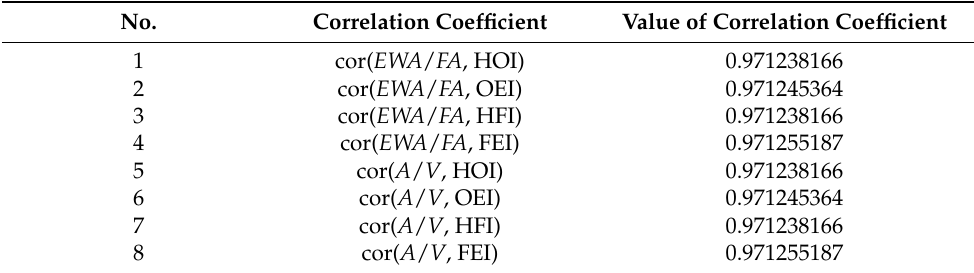
Table 6. The correlation coefficients of the EWA / FA and A / V (shape parameters) with HOI, OEI and HFI, FEI (demand energy parameters) of buildings belonging to H1–H30.